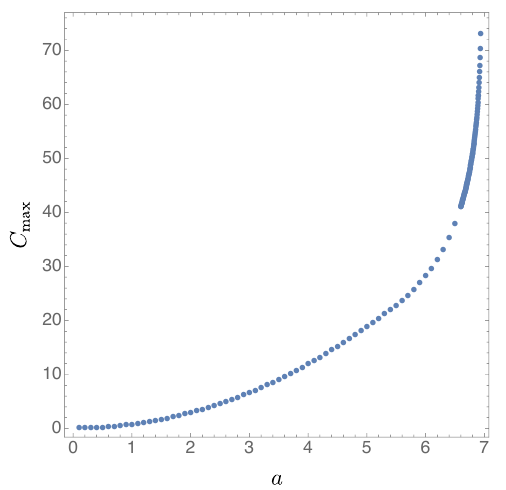
Figure 4 . Maximum value of C abcd C abcd over spacetime, computed with n = 8, as a function of a .